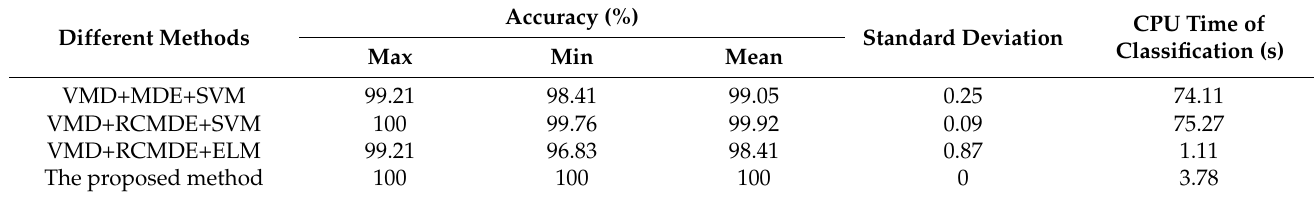
Table 5. Classification results of different